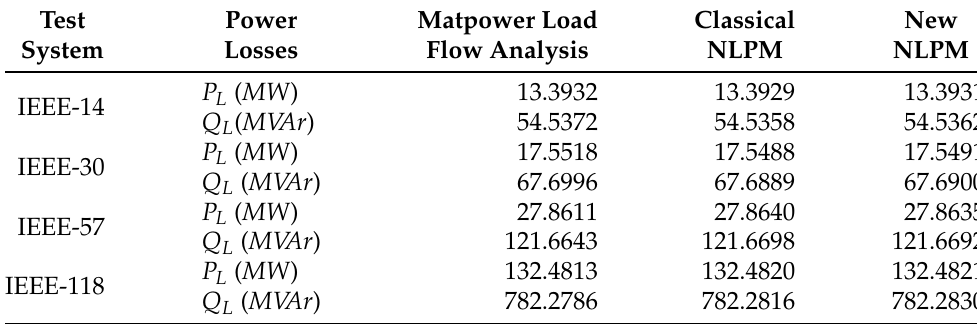
Table 5. Power loss for IEEE systems without bad data measurements.